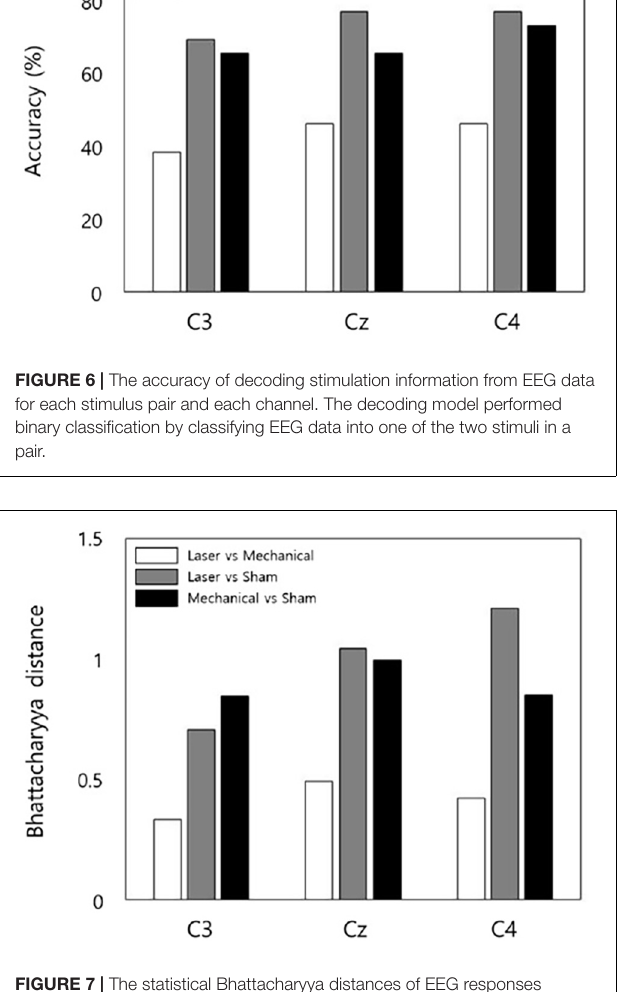
FIGURE 7 | The statistical Bhattacharyya distances of EEG responses between a pair of stimuli for each channel. Shorter distances indicate more similar EEG responses to a pair of stimuli. Note that no error bar showing the variability across subjects is included here since the Bhattacharyya distance was measured using the EEG data of all